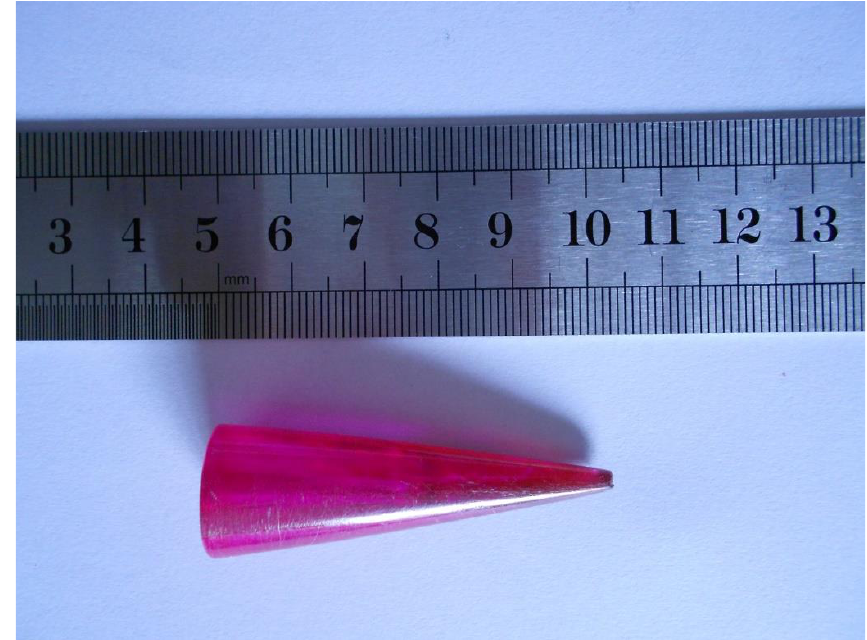
Figure 2. Image of Bridgman-grown 0.1 wt.% pentacene-doped p-terphenyl crystal.